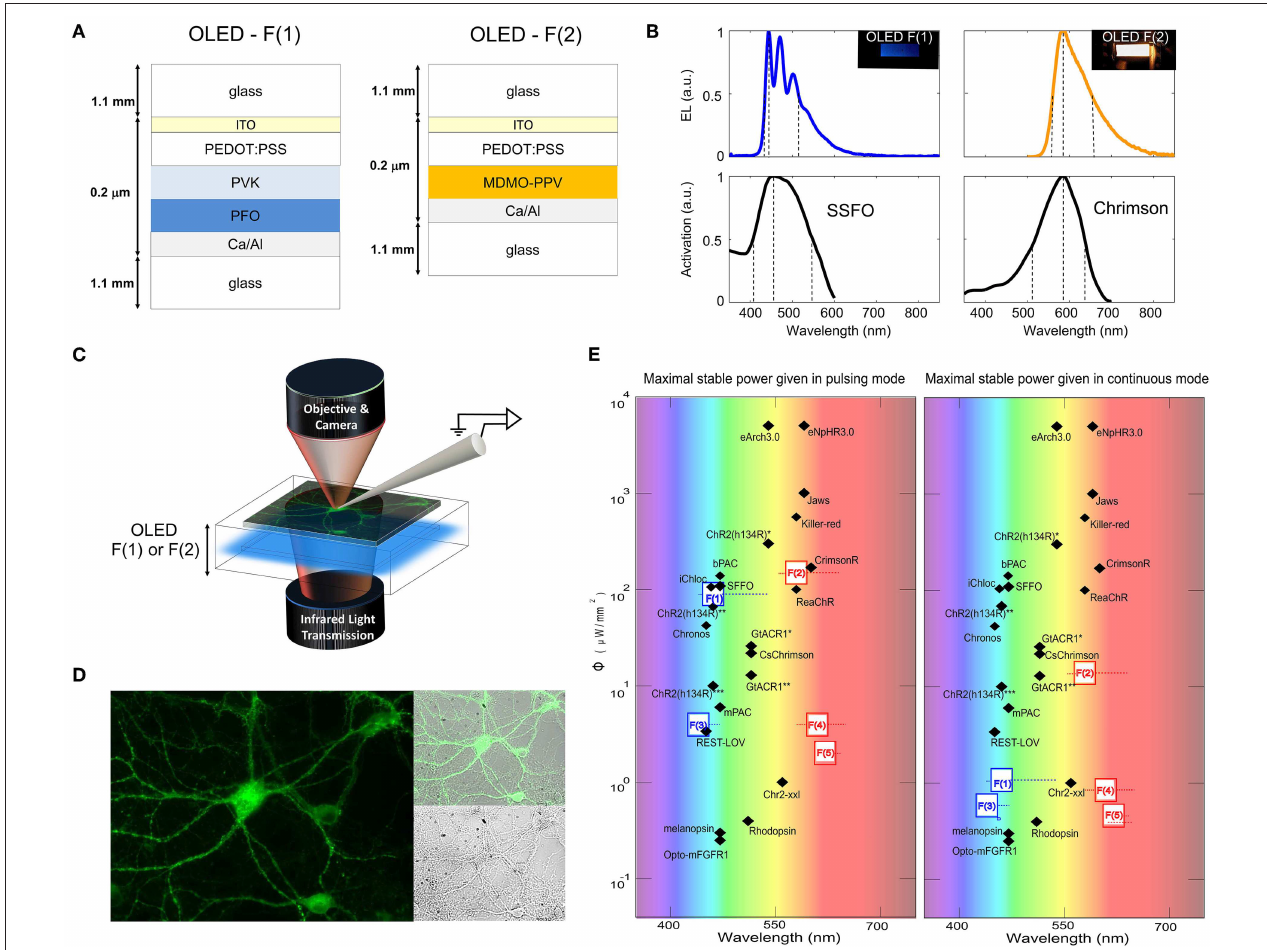
FIGURE 1 | Blue and orange OLEDs based on PFO and SO-PPV use for photo-activation of SSFO and ChrimsonR, respectively. Device architectures (A) and emission spectra (B) for blue PFO and orange SO-PPV OLEDs. (C) Due to the use of a thin ( < 100nm) Al-capping layer, both sets of devices were translucent in the near infrared range, allowing simultaneous photo-stimulation and patch-clamp recordings guided by infrared transmission and epifluorescence. (D) Fluorescence images of neurons expressing eGFP and located at the surface of the blue PFO OLED, alongside the near infrared transmission image. (E) Maximal optical output of solution-processed blue and red-shifted OLEDs with respect to the activation requirements of a toolbox of optogenetic probes. Fluorescent OLEDs are represented with their active layer number F(x) and following Glass/ITO/Pedot:Pss/F(x)/Ca/Al structure with PFO and PVK for F(1) devices; Super Orange (SO-PPV) for F(2) devices; PFO for F(3); MEH-PPV for F(4); CN-PPV for F(5). References for OPSIN tools are: ChR2-XXL (Dawydow et al., 2014); Rhodopsin (Cehajic-Kapetanovic et al., 2015); Jaws (Chuong et al., 2014); ChR2(H134R) (Yu et al., 2015); Killer Red (Williams et al., 2013); GtACR1*, GtACR1** (Govorunova et al., 2015); CsChrimson (Mohammad et al., 2017); Melanopsin (Beiert et al., 2014); bPAC (Stierl et al.,